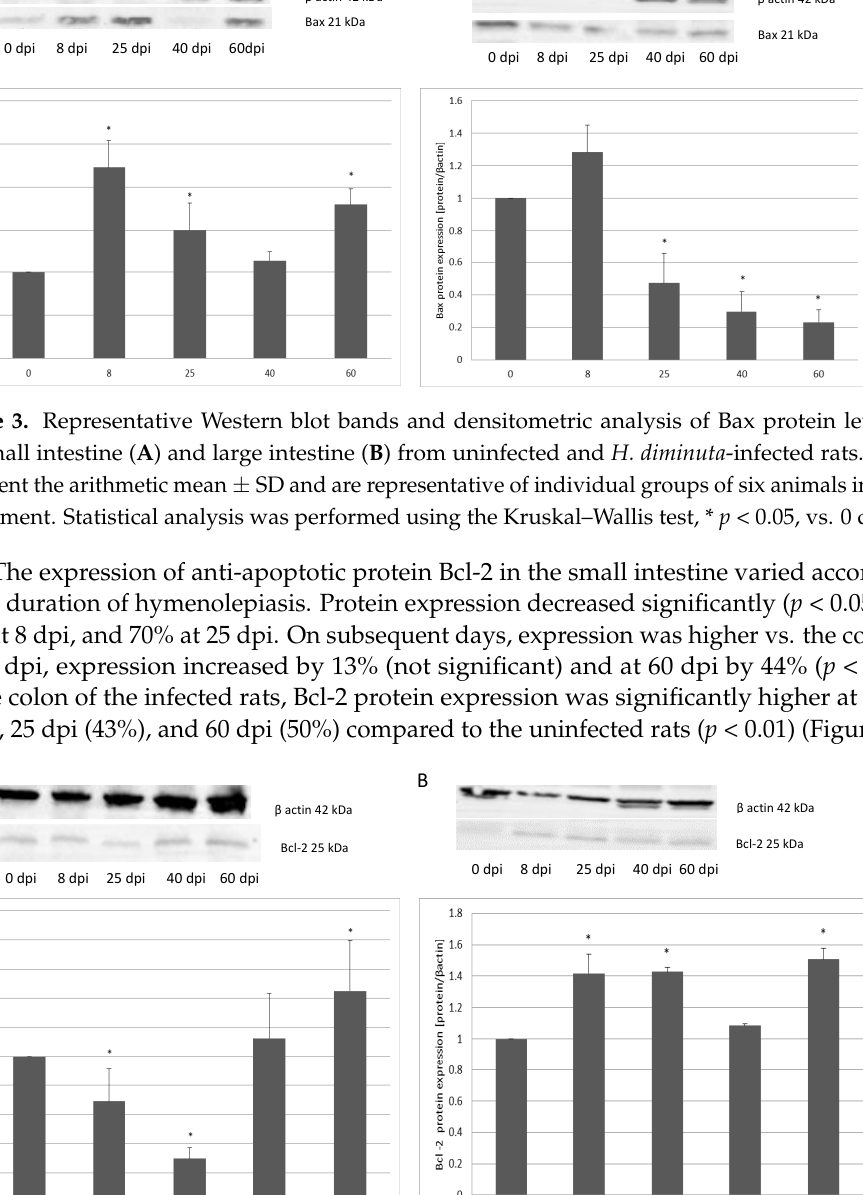
Figure 4. Representative Western blot bands and densitometric analysis of the Bcl-2 protein level in the small intestine ( A ) and large intestine ( B ) from uninfected and H. diminuta -infected rats. Data represent the arithmetic mean ± SD and are representative of individual groups of six animals in each experiment. Statistical analysis was performed using the Kruskal–Wallis test, * p < 0.05, vs. 0 dpi. In the small intestine, caspase-3 protein expression was the highest at 40 dpi, and it was 20% higher compared to the control group ( p < 0.05). On subsequent days,